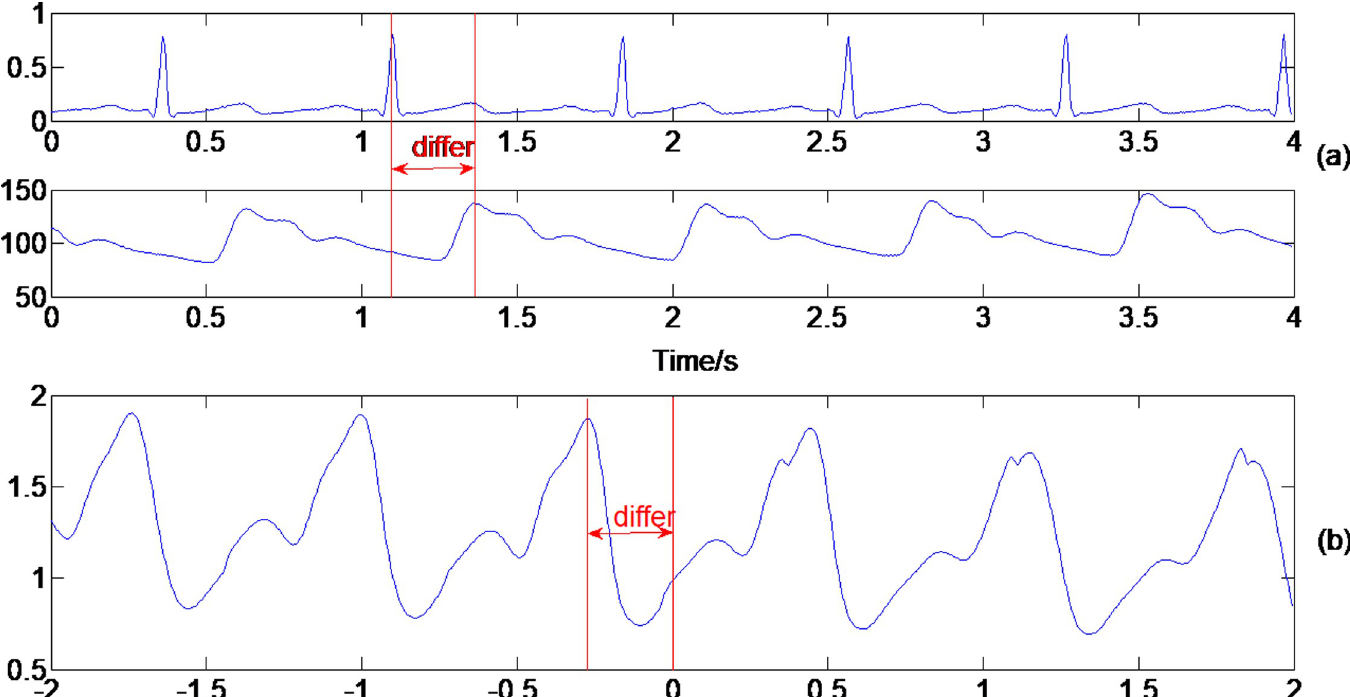
Fig 2. Determination of the time delay ‘differ’ between the corresponding peaks of the ECG and BP. (a) Illustration of the ‘differ’ between the ECG and continuous BP; (b) Cross-correlation function to determine the ‘differ’.